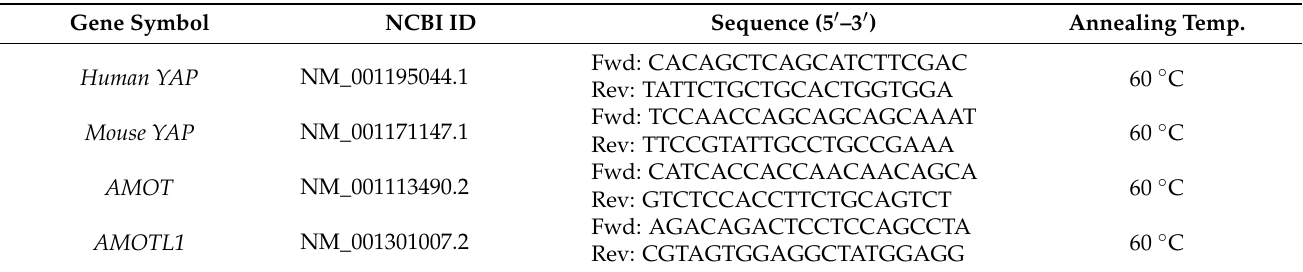
Table 1. Oligonucleotide sequences of primers used for RT-PCR and